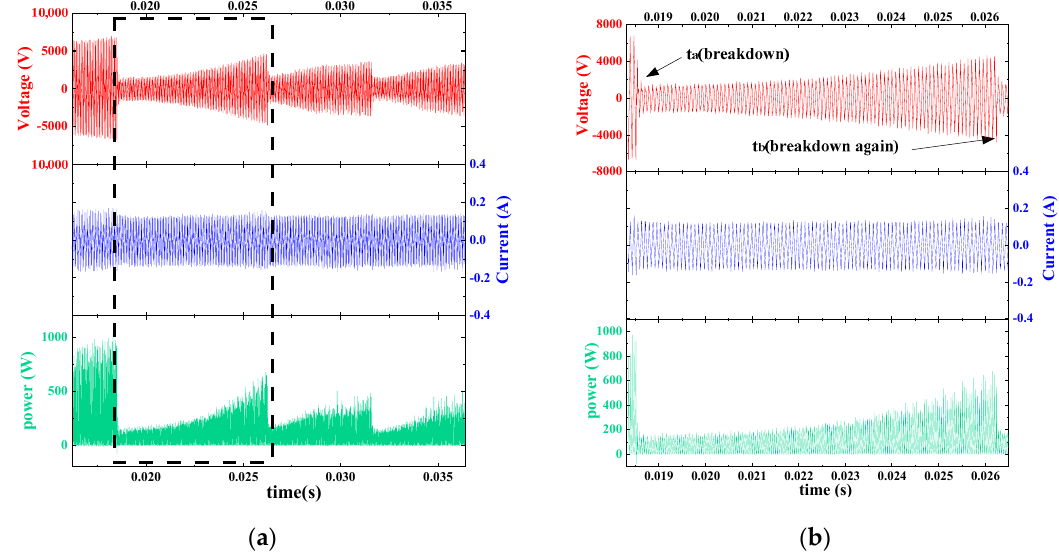
Figure 5. ( a ) Voltage, current, and power waveforms of the gliding arc discharge when average flow rate in stable mode was 30SLM. ( b ) Zoomed-in view voltage, current, and power waveforms (from t = 0.0183 s to t = 0.0265 s).